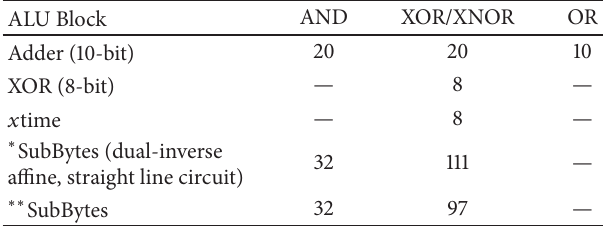
Table 7: Gate counts on ALU